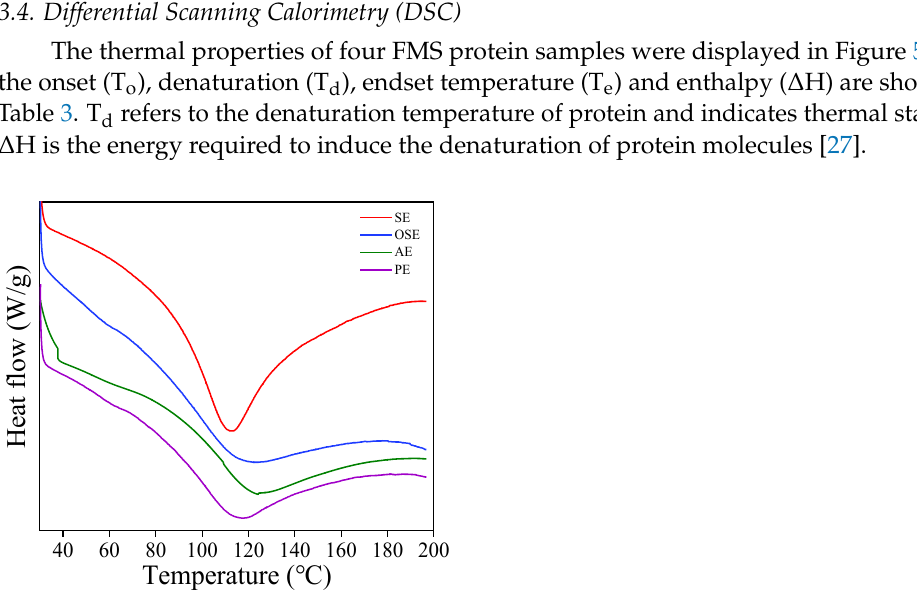
Figure 4. Intrinsic fluorescent spectrum of field muskmelon seeds protein extracted by different oil extraction methods.